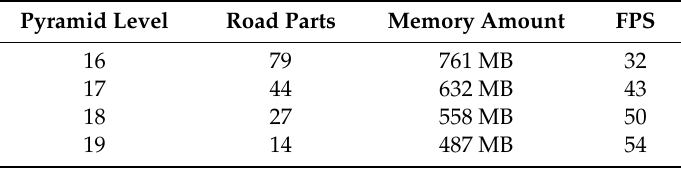
Figure 15. Large-scale road network simulation. Table 1. Large-scale road network rendering results.